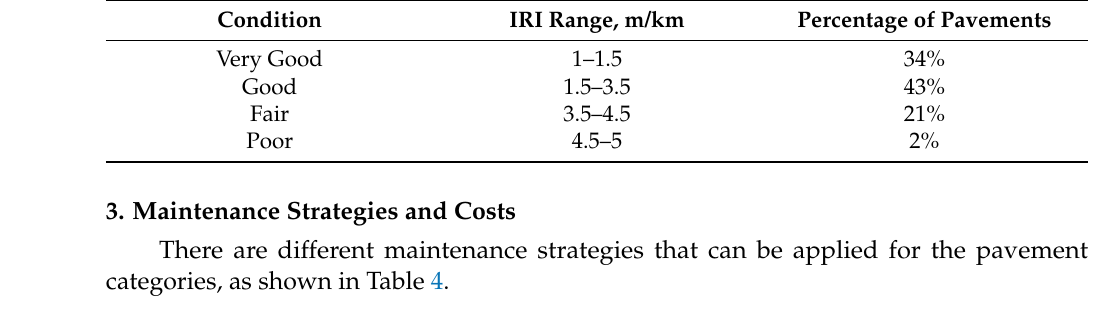
Table 4. Maintenance strategies used in Munster for different pavement